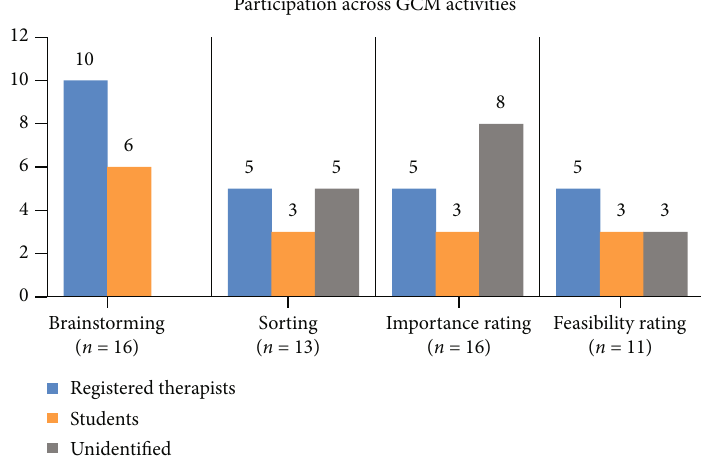
Figure 1: Bar chart showing participation across each GCM activity. Participants were asked to identify as a student or registered occupational therapist. Not all participants responded to demographic questions, leaving some participants ’ titles as “ unidenti fi ed. ”